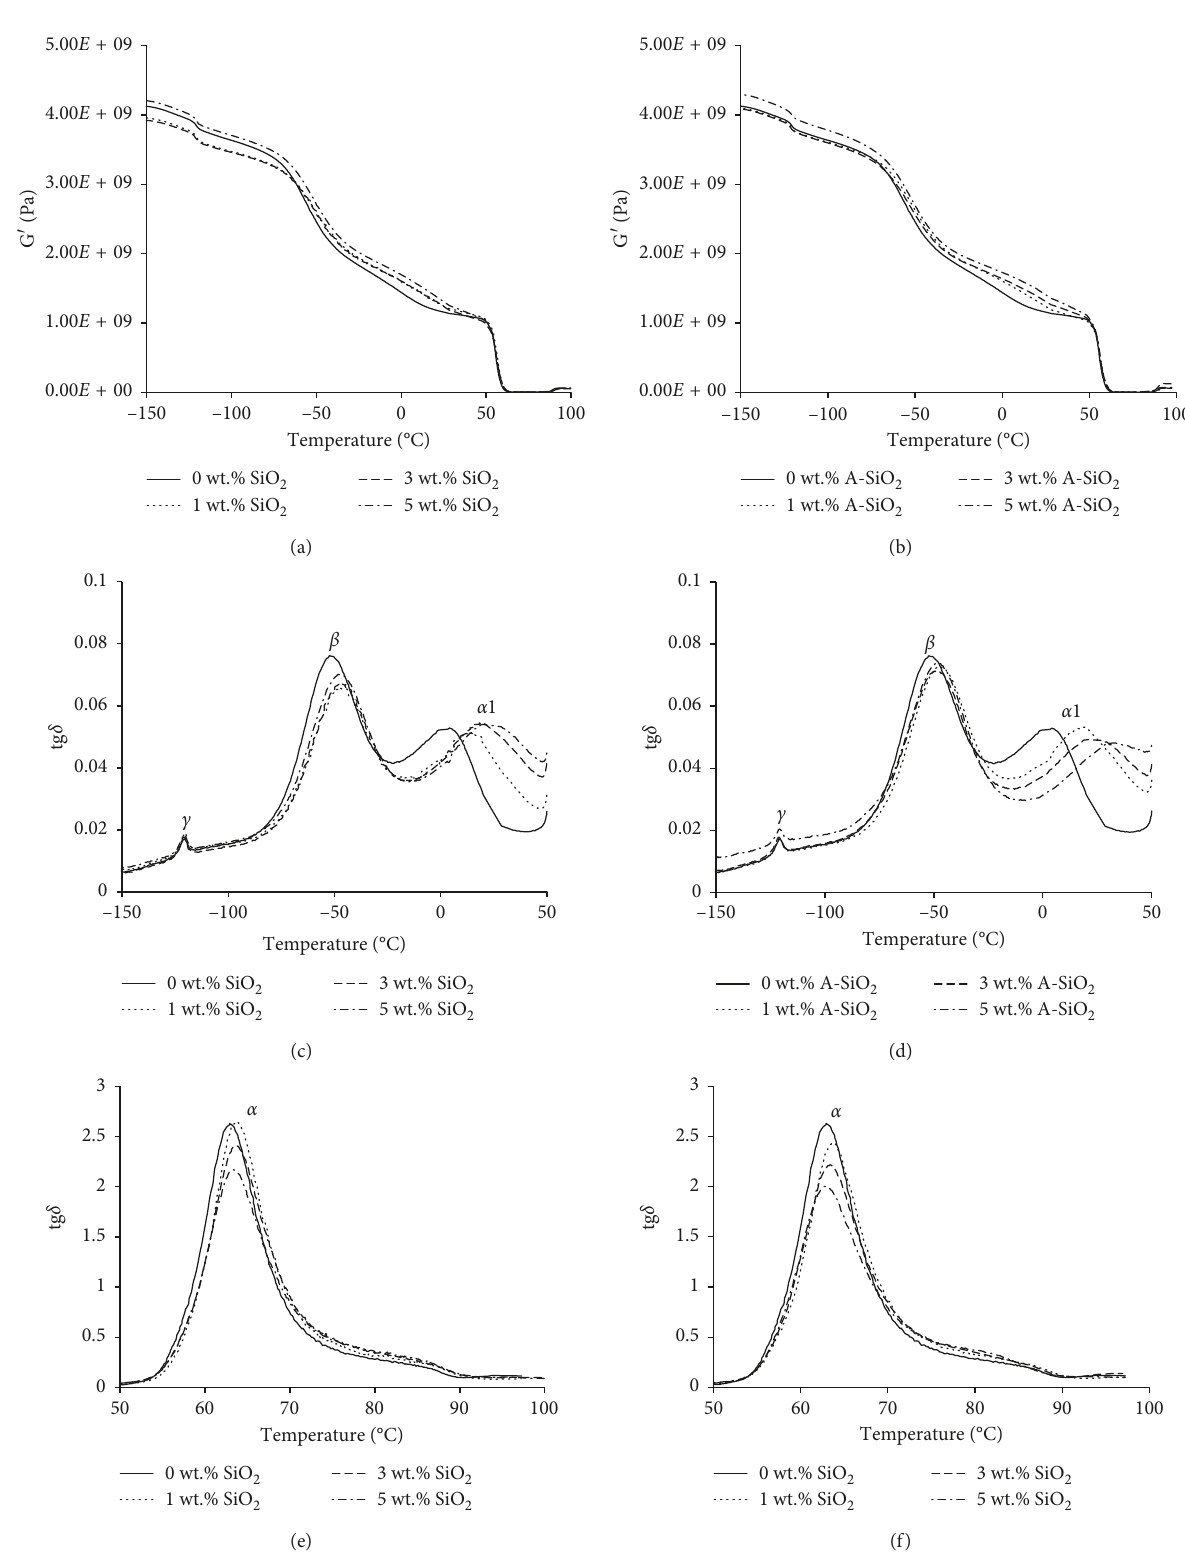
Figure 11: Dependence of G ′ and tg δ of various composites on